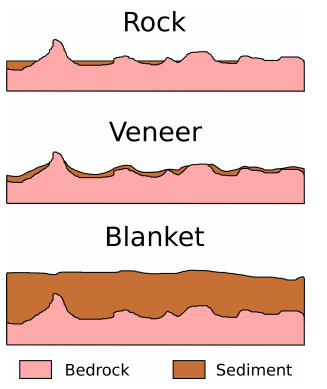
Figure 4. Illustration of how the sediment distribution relates to the underlying bedrock and thickness of the sediments. The rock class has only isolated patches of sediment, the veneer class has a thin sediment layer with bedrock outcrops and a visible influence of bedrock topography on the surface, while with the blanket class, the sediments completely obscure the bedrock surface.